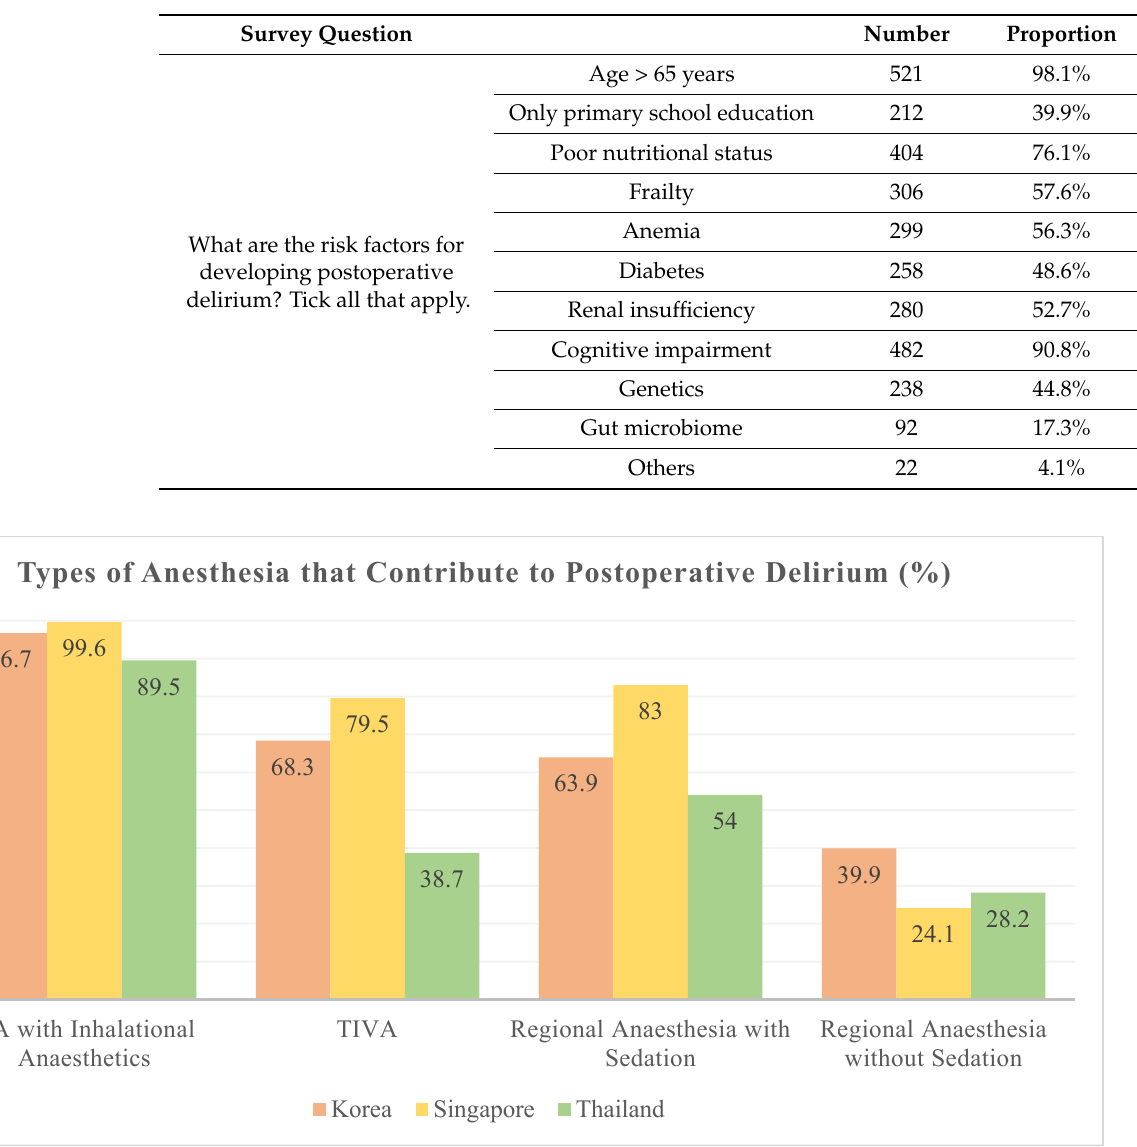
Table 3. Perceived risk factors for developing postoperative delirium among the survey respondents.